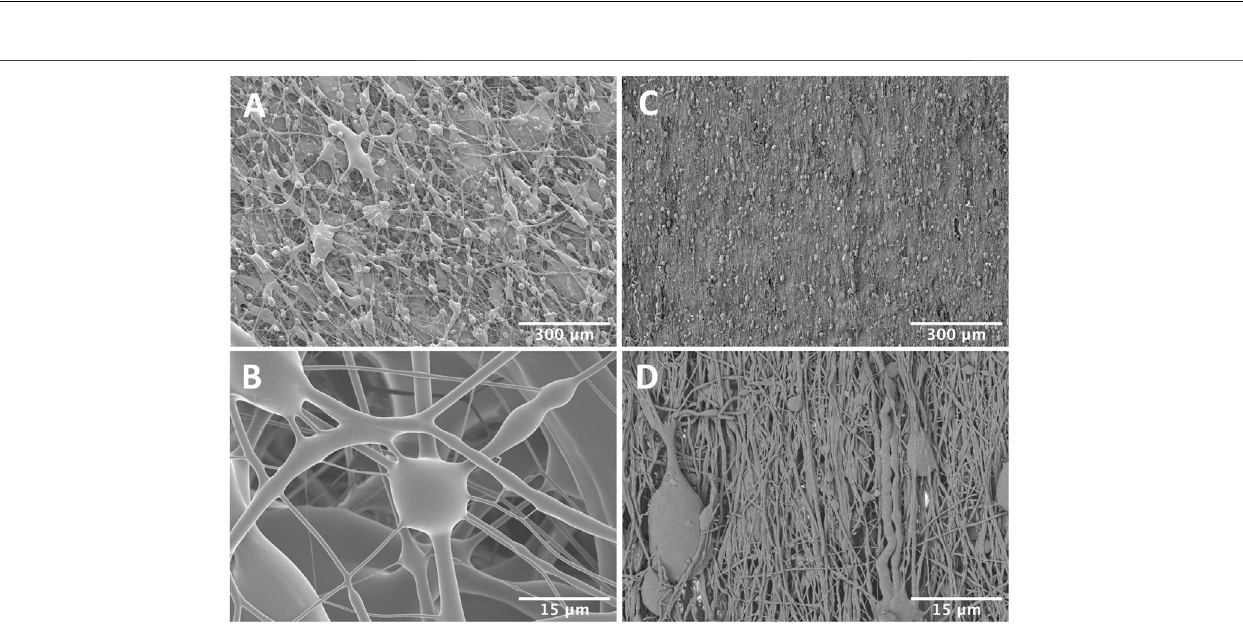
Frontiers in Bioengineering and Biotechnology |